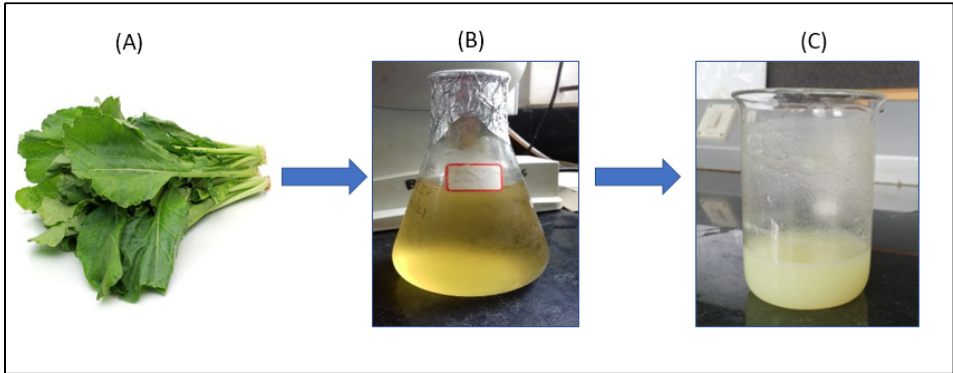
Figure 2. Green synthesis of ZnONPs ( A ) R. sativus leaves, ( B ) Leaf extract, ( C ) ZnONPs.